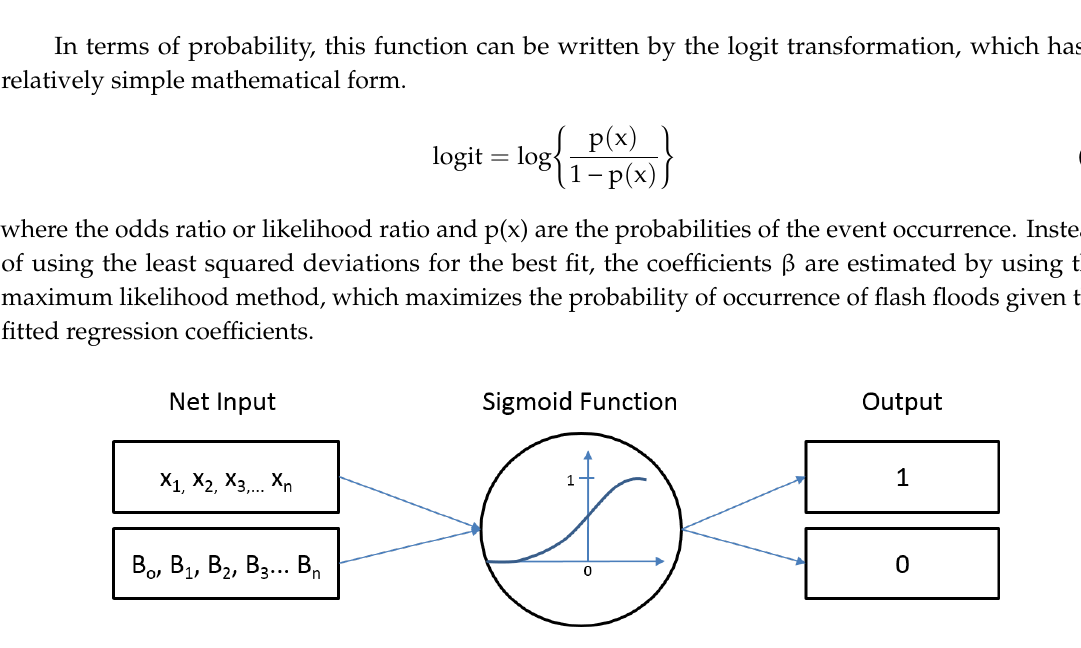
Table 1. Evaluation of logistic regression models for predicting flash floods.